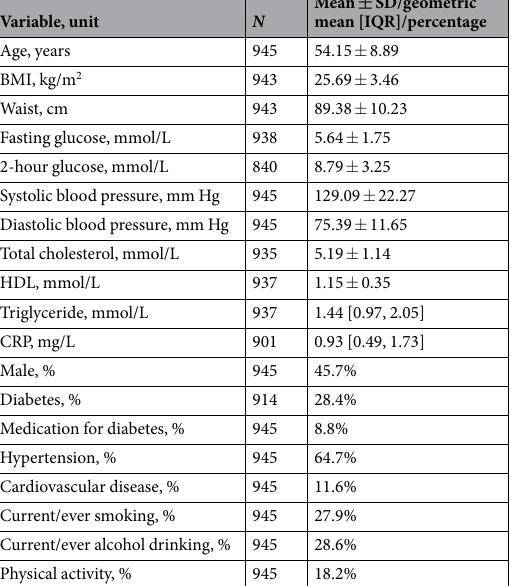
Table 1. Clinical characteristics of the study sample. N , number of subjects having available data; SD, standard deviation; IQR, interquartile